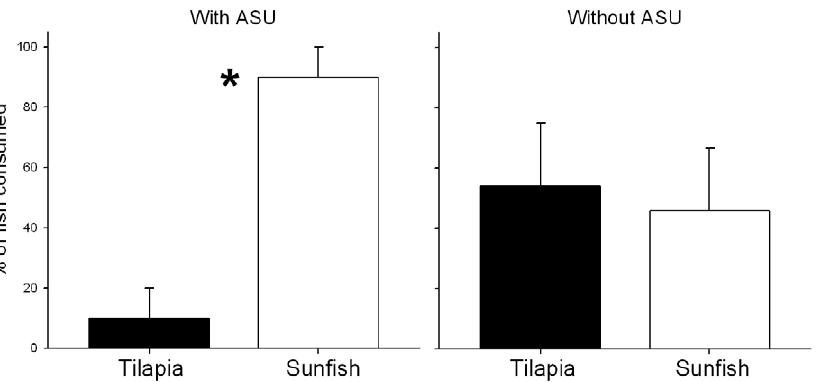
Figure 2. Consumption of tilapia and sunfish by largemouth bass (mean % ± 1 standard error) with (a) and without (b) artificial structure as a refuge. Asterisk indicates significant differences between species (p #